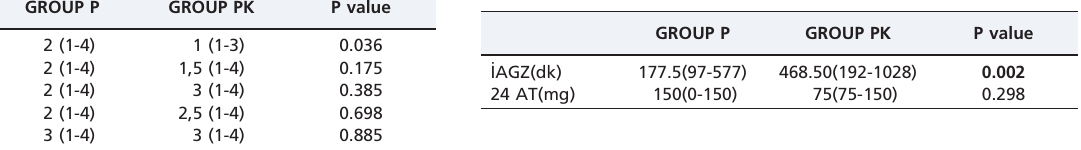
Table 7 - Time to first analgesic requirement, 24-hour analgesic consumption (median value, minimum- maximum).